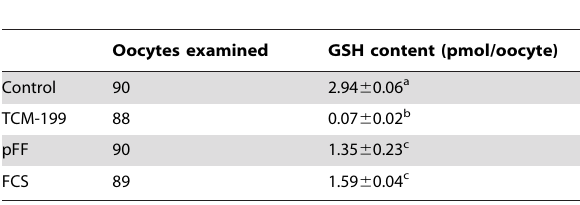
Table 3. Maturation of oocytes after preservation at 27.5 u C in different media.